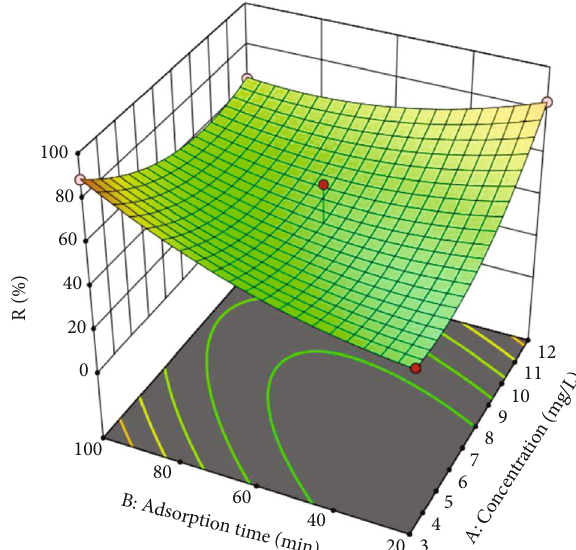
Figure 2: E ff ects of adsorption time and concentration on adsorption rate.